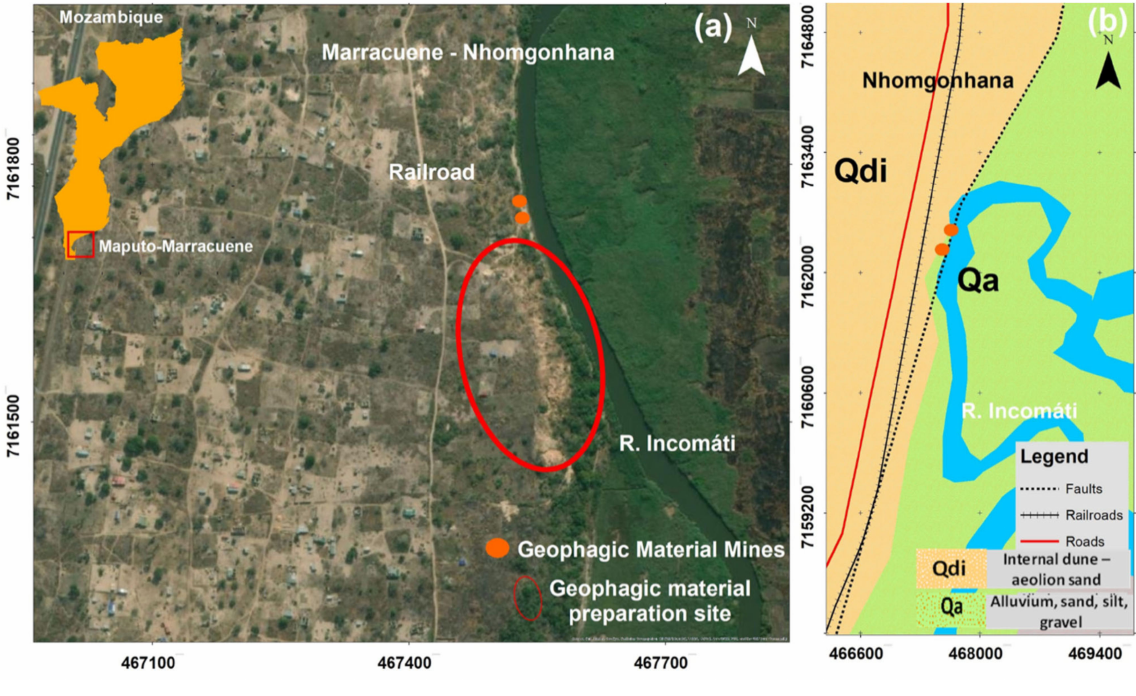
Figure 1. ( a ) Location of the Geophagic Materials Mines; ( b ) Geology.